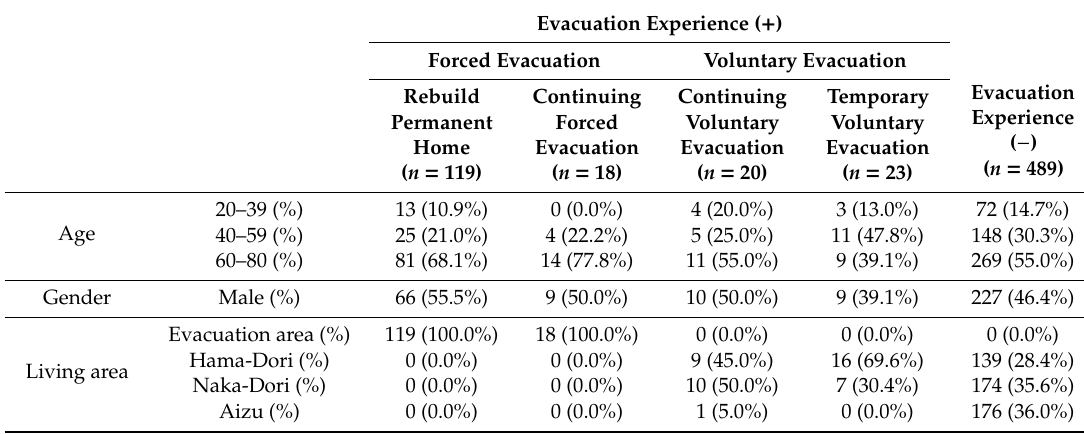
Table 1. Basic characteristics of